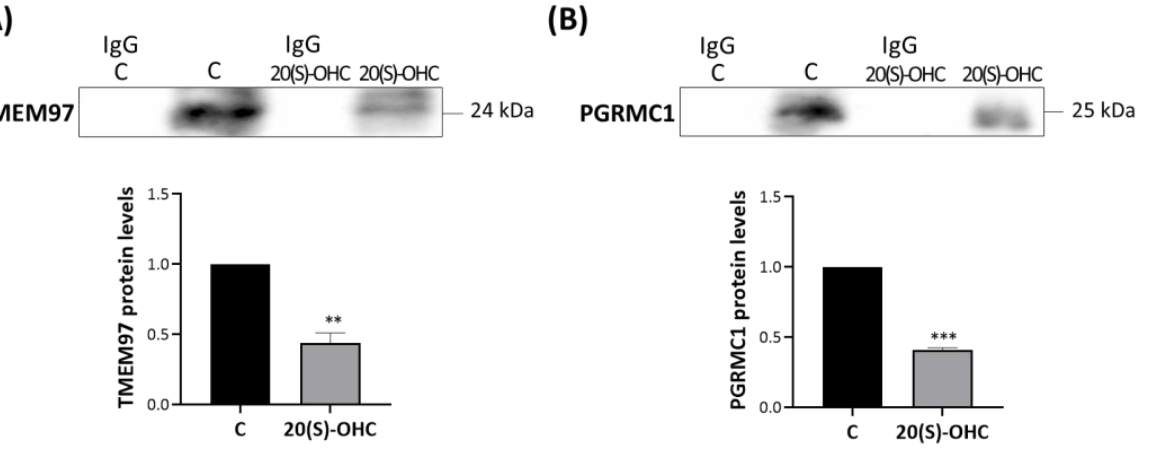
Figure 5. 20S-OHC reduces levels of both TMEM97 and PGRMC1 co-immunoprecipitated with TSPO. MP cells were treated for 24 h with 20S-OHC, immunoprecipitated with an antibody directed against TSPO, and the immune pellets were analyzed by Western blot with anti-TMEM97 ( A ) or anti-PGRMC1 ( B ) specific antibodies. IgG is the negative control for the anti-TSPO experimental treatment immunoprecipitation. Western blotting data are representative of at least three independent experiments. TMEM97 ( A ) and PGRMC1 ( B ) protein levels in 20S-OHC treated cells were normalized versus proteins in untreated cells (C) and reported in the respective graph bars as means ± SD (error bars). Statistical significance of the differences was evaluated by using Student’s t -test (** p < 0.01, *** p < 0.001).